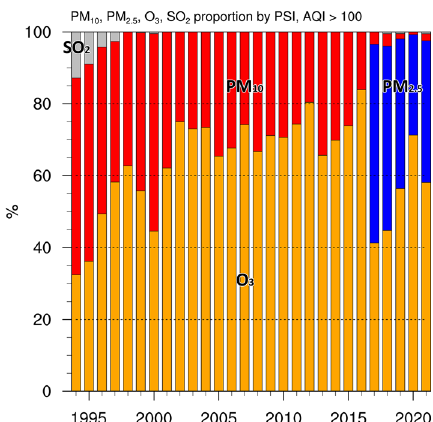
Fig. 1 The incidence of the major air pollutants in severe air quality conditions defined by the PSI and AQI over 100. PM 10 , PM 2.5 , O 3 and SO 2 are shown in red, blue, orange and